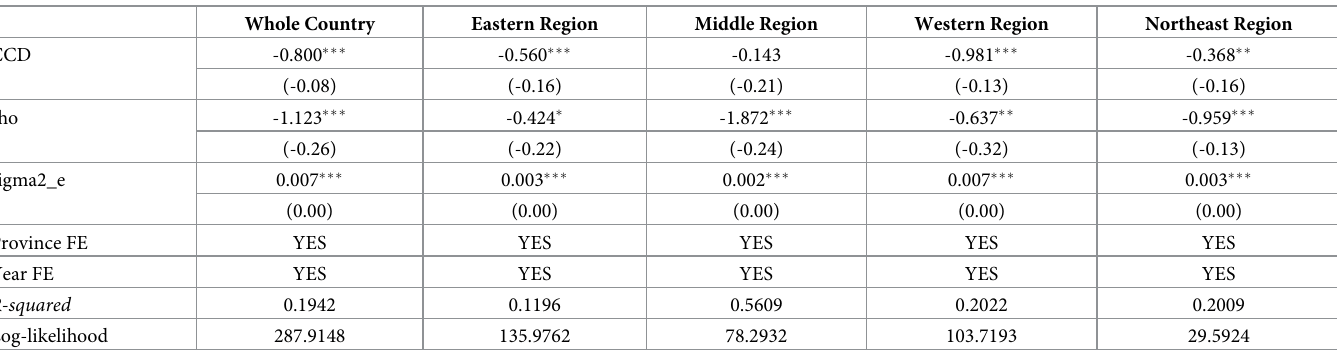
Table 3. Regression